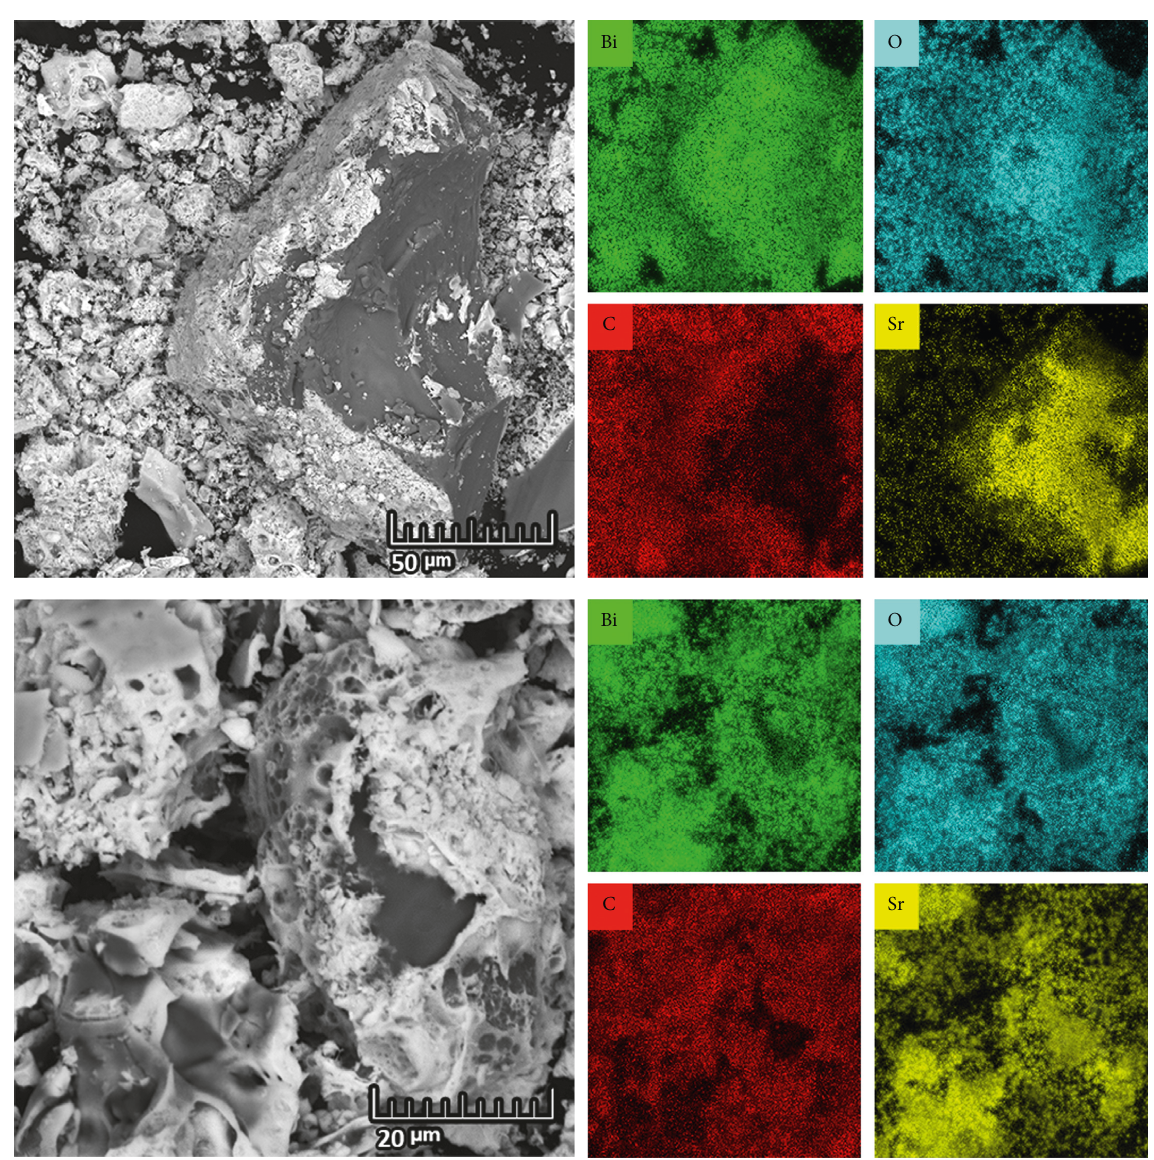
Figure 2: SEM images of composed SBC-500 and results of mapping. Table 1: The content of semiconductor phases in the obtained